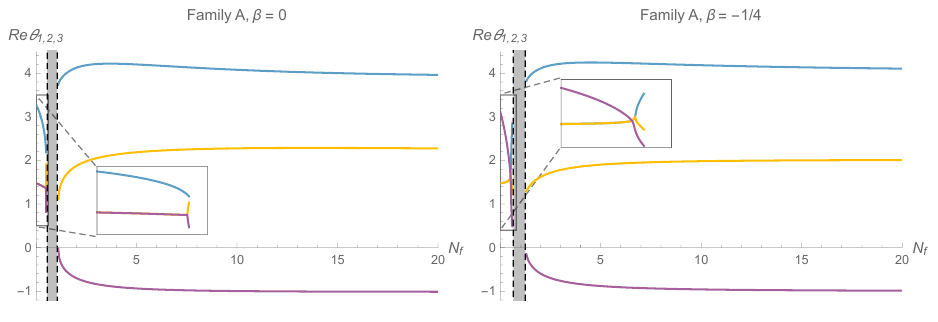
Figure 8. Results from the numerical investigation of the NGFPs belonging to Family A . Reading the diagrams from top-left to bottom right, the first three plots show the position of the fixed points as a function of N f . The blue and yellow lines correspond to the choice in coarse-graining operator, β = − 1/4 and β = 0, respectively. The fermion anomalous dimension η ∗ diagram. The stability coefficients are plotted in the bottom row of the diagram indicating that the fixed points come with two UV-attractive and one UV-repulsive eigendirection once N f exceeds the upper bound of the window